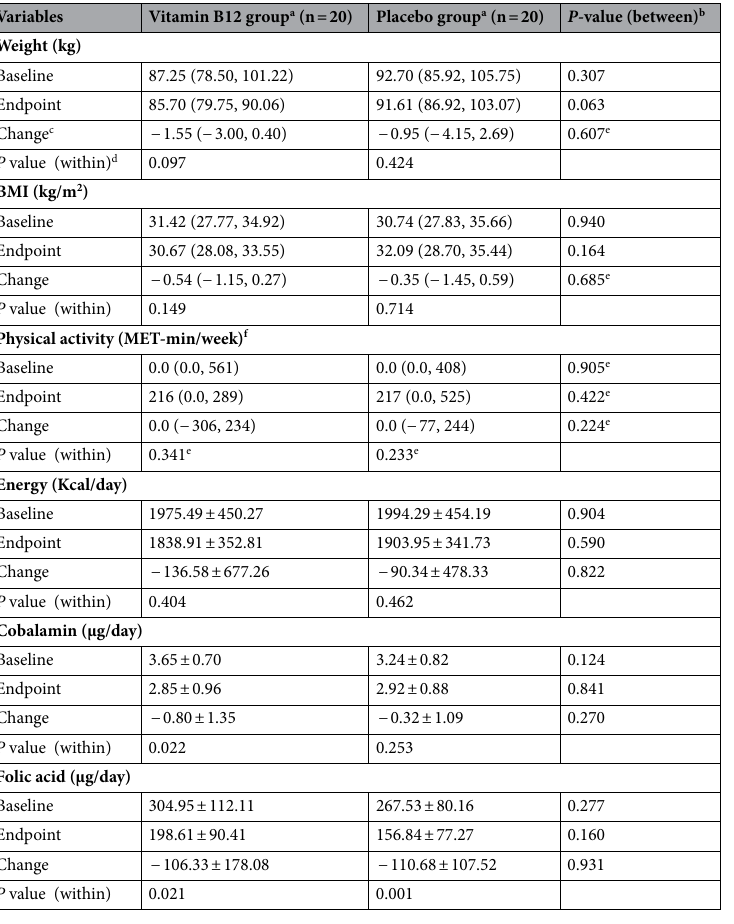
Table 2. Within-group and between-group comparisons of the baseline, endpoint and changes values for anthropometric, physical activity, and dietary variables in vitamin B12 and placebo groups. BMI body mass index, MET metabolic equivalent of task. a Values are expressed as mean ± standard deviation or median (25th, 75th percentiles). b P -value for comparing the values between the study groups at baseline, at the endpoint and the change from baseline. Two sample t-test and Mann–Whitney U test were used for parametric and non-parametric comparisons, respectively. c Endpoint values minus the baseline ones. d P -value for comparing baseline with the end point values within each group. Paired sample t-test and Wilcoxon Paired Rank test were used for parametric and non-parametric comparison, respectively. e P -value obtained from a non-parametric test. f Total MET-minutes/week = Walking (3.3METs × min × days) + Moderate intensity (4 METs × min × days) + Vigorous intensity(8METs*min*days), based on the short form of International Physical Activity Questionnaire